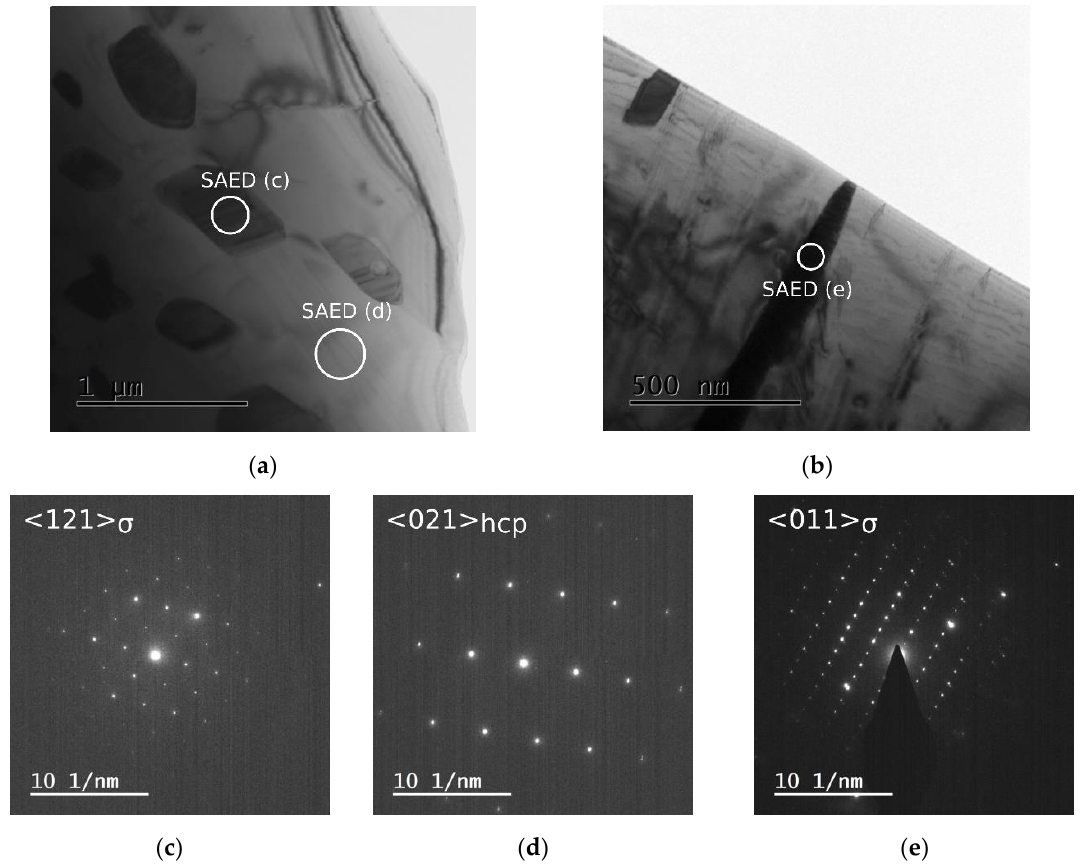
Figure 11. Microstructure of the 3D-printed alloy after 1200 °C/2 h + 900 °C/5 h heat treatment: ( a ) TEM image of grain boundary precipitates; ( b ) TEM image of rod-like precipitates; ( c – e ) diffraction patterns.